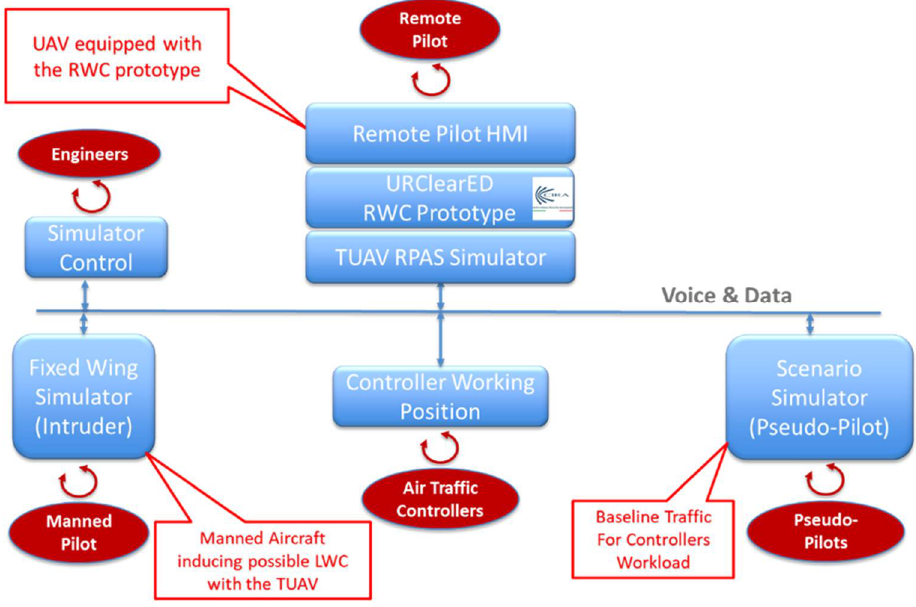
Figure 14. Real-time simulation facility architecture.